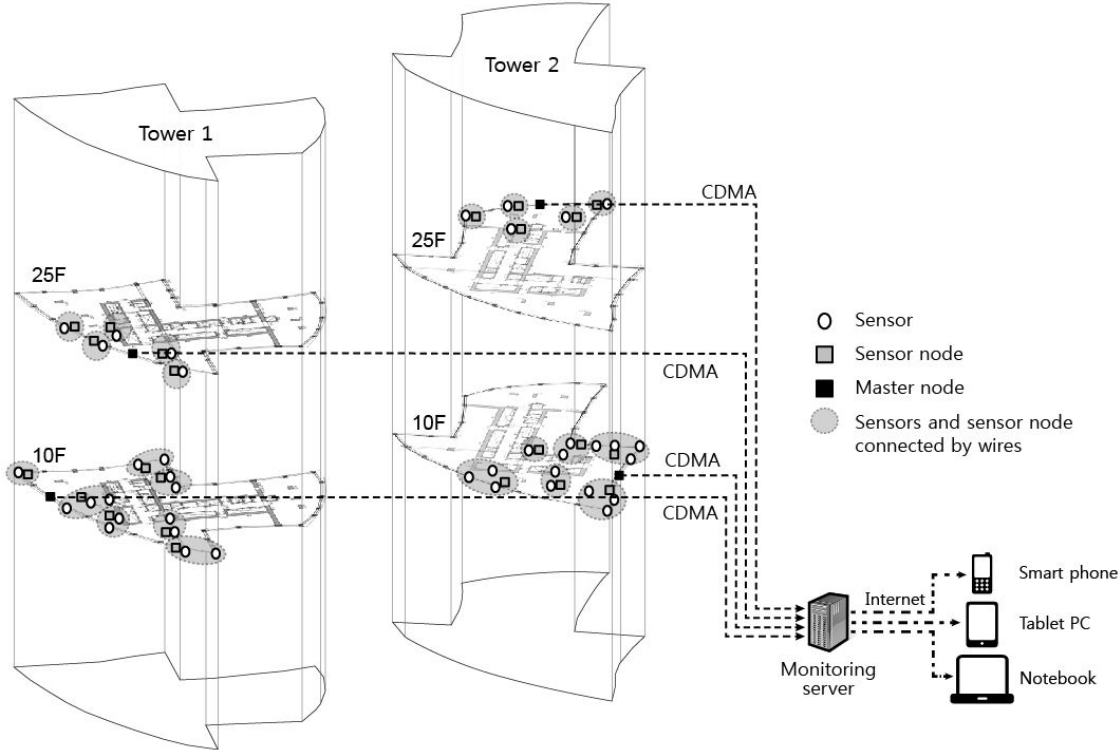
Figure 7. Location of sensor nodes and master nodes for field measurement of column shortenings in tower 1 and tower 2.